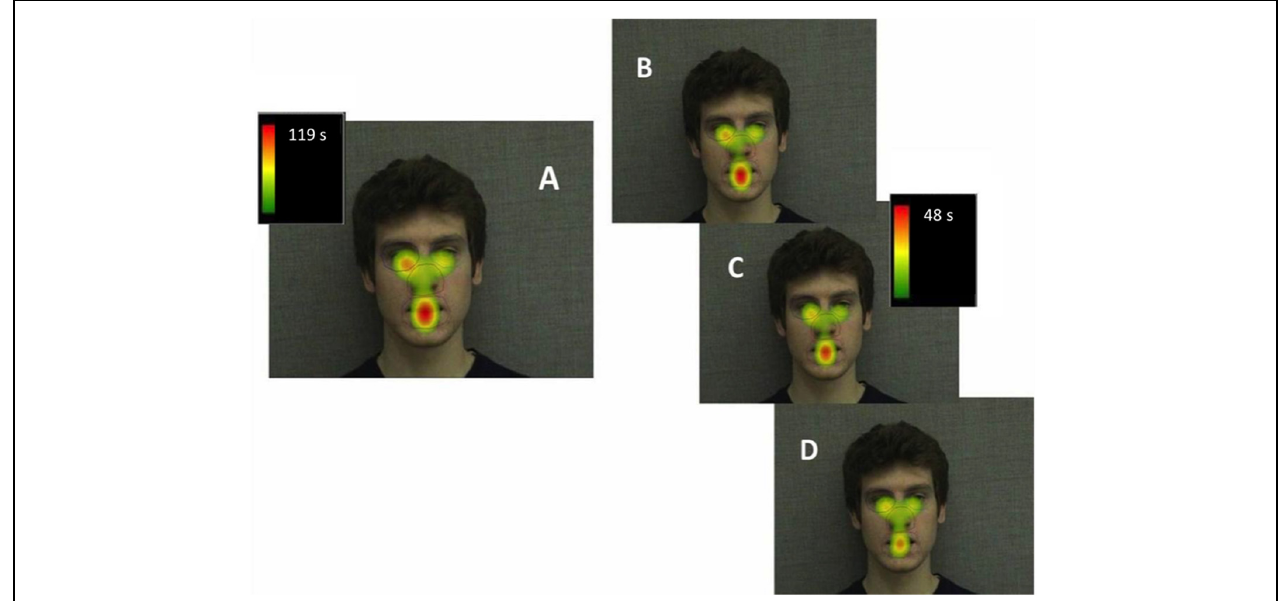
FIGURE 3 | Heatmap illustrating mean total gaze durations (seconds) in each area of interest across the entire familiarization (A), in block 1 (B), block 2 (C), and block 3 (D).